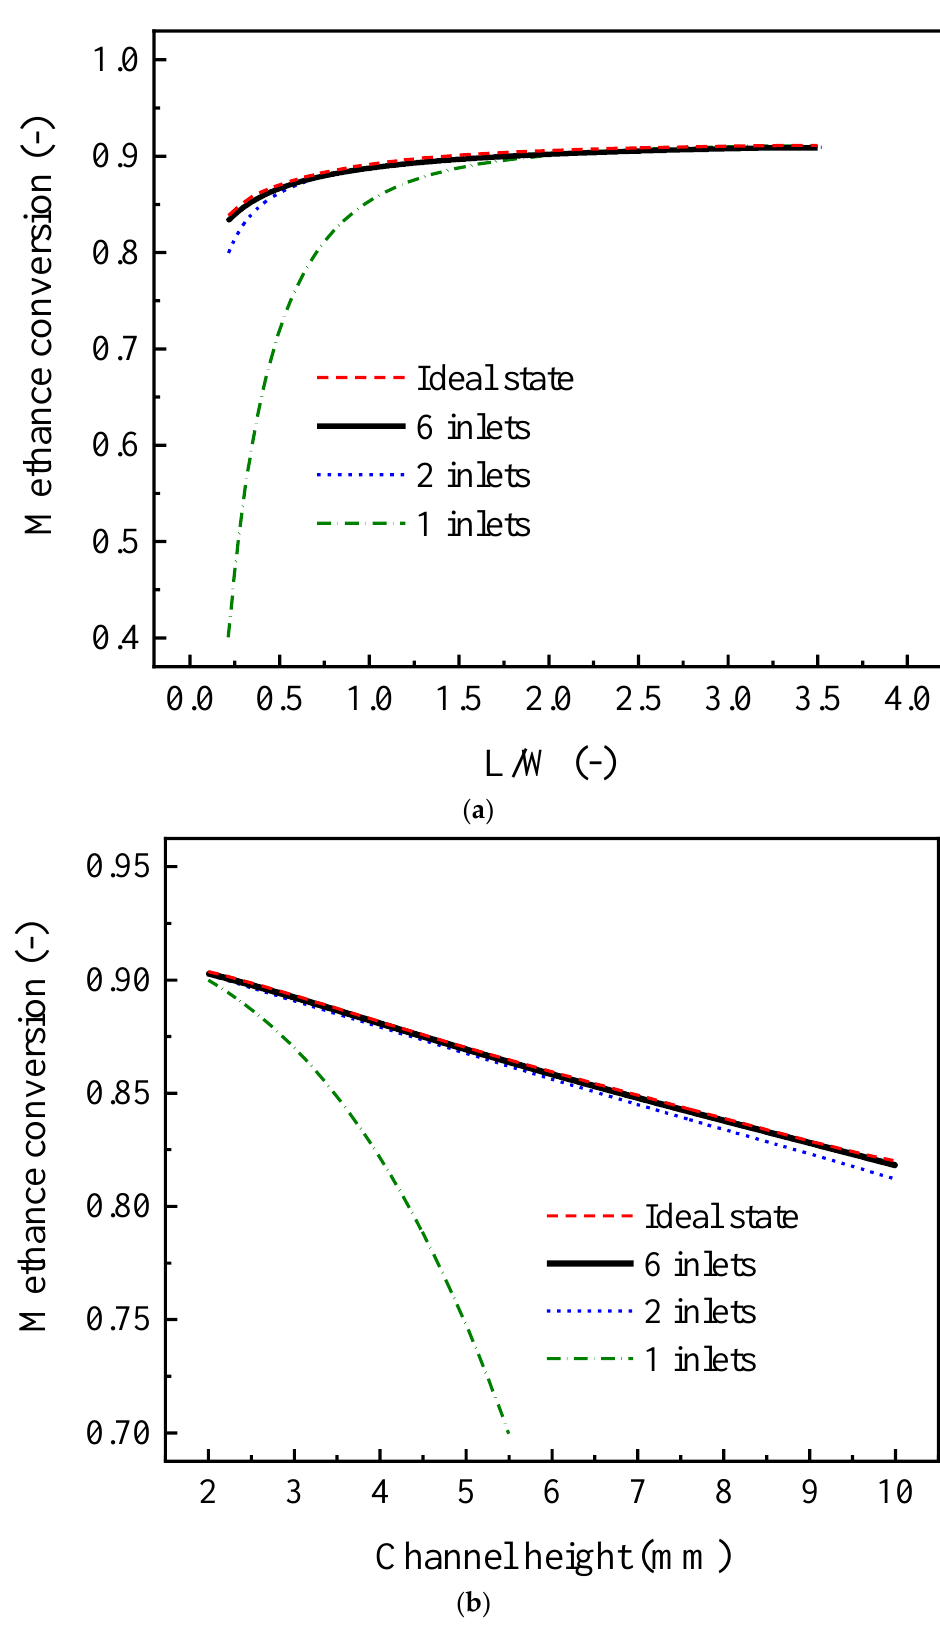
Figure 15. Relationship between the number of inlet ports and the performance of the box-type channel at different L/W ( a ) and channel height ( b ) (F/w = 100,000 mL/g-cat/h, W = 2 cm). In the case of a single inlet port, the undesirable inlet gas distribution state leads to poor reformer performance, due to insufficient transverse mass transfer and severe back- mixing. As is shown in Figure 16a, the gas velocity profile indicates that the inlet feed is poorly distributed in the reactor, creating a large stagnant region. The inhomogeneous distribution of the methane concentration along the Y-axis (Figure 16c) indicates insuffi- cient transverse mass transfer. The flux streamline (Figure 16b) shows that a large vortex is formed in the case of a single inlet port, resulting in serious backmixing and a low reac- tion rate. Figure 16. Velocity distribution ( a ), streamline of gas ( b ) and concentration of methane ( c ) of a box- type channel with a single inlet (F/w = 100,000 mL/g-cat/h, W = 2 cm). 4.3.7. Comparison of Tube-Type and Box-Type Channels The different structures of the two reformers make them very different in terms of performance and manufacturing difficulties. The tube-type channel consists of a cylindri- cal catalyst, which tends to produce a homogeneous distribution of the gas flow near the inlet and inside the channel. In contrast, the box-type channel has no catalyst on either